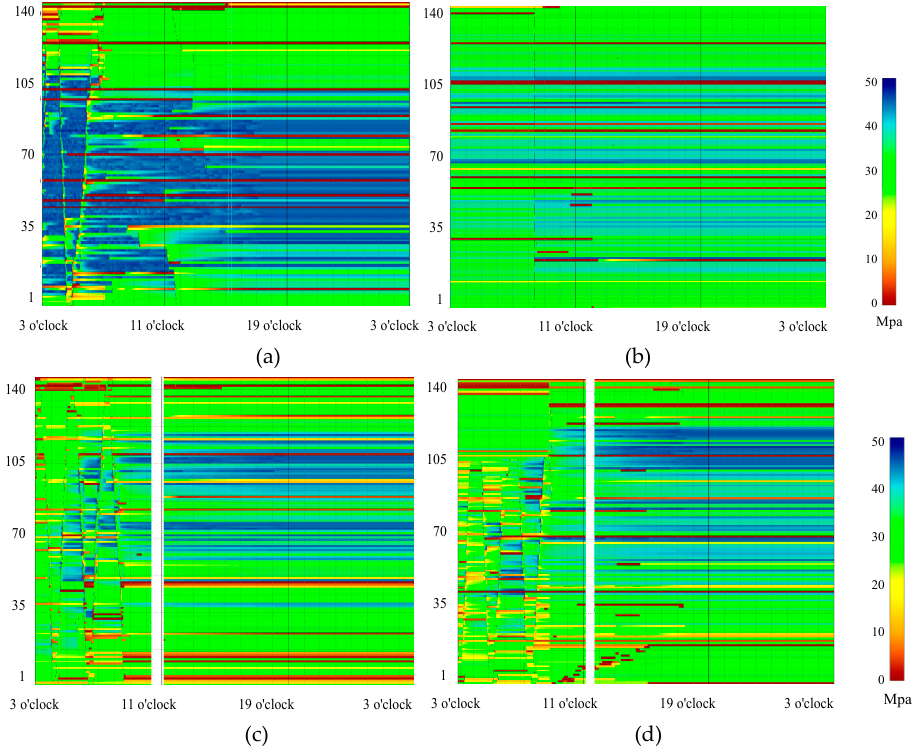
Figure 11. The online monitoring report at different times: (a) FW; (b) FPW; (c) SPW; (d) TPW.